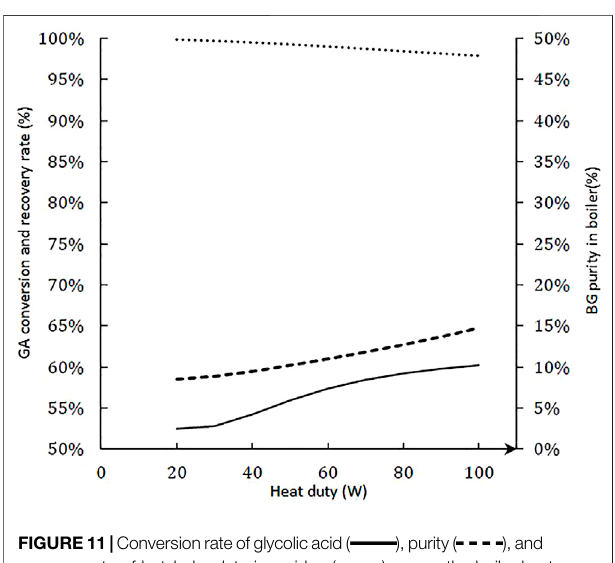
FIGURE11| Conversionrateofglycolicacid( ),purity( ),and recovery rate of butyl glycolate in residue ( ) versus the boiler